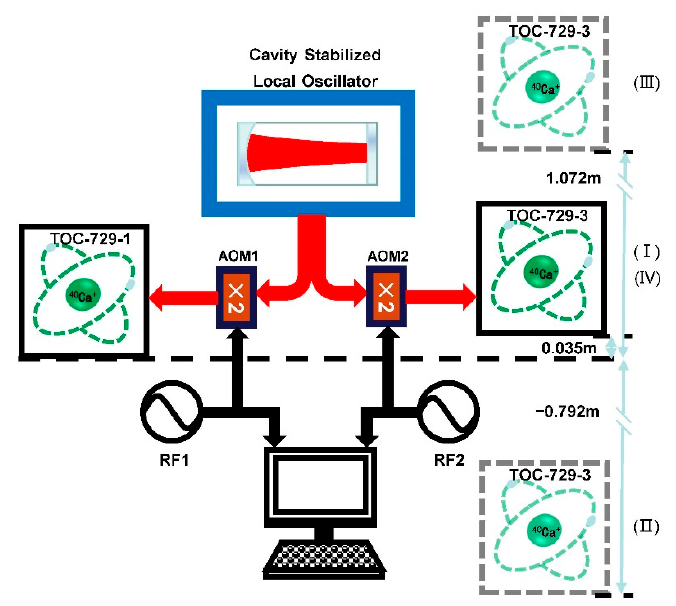
Figure 3. Flow diagram of using APM clocks for chronometric leveling [36].